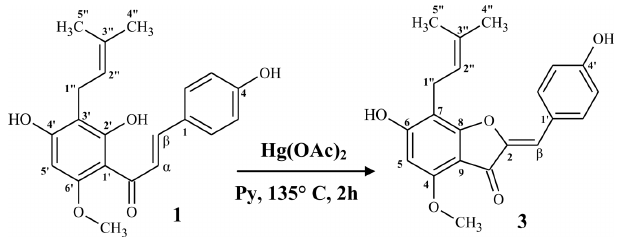
Figure 2. Synthesis of ( Z )-6,4’-dihydroxy-4-methoxy-7-prenylaurone ( 3 ) from xanthohumol ( 1 ).